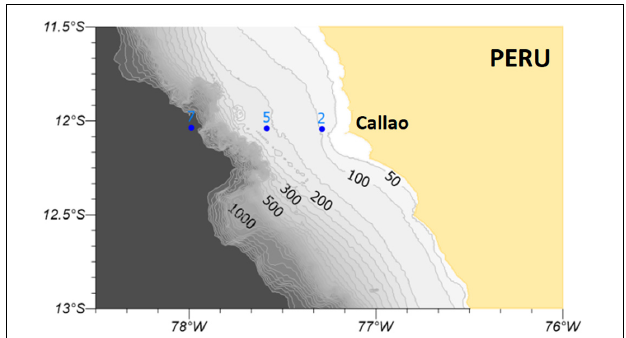
FIGURE 1 | Perpendicular transect of stations located off central Peru (Callao –12 ◦ S) sampled for DOM during April, August, and December 2015. The contour lines shown in the map represent bathymetric isolines. Numbers mark stations: 2 (station 2), 5 (station 5), and 7